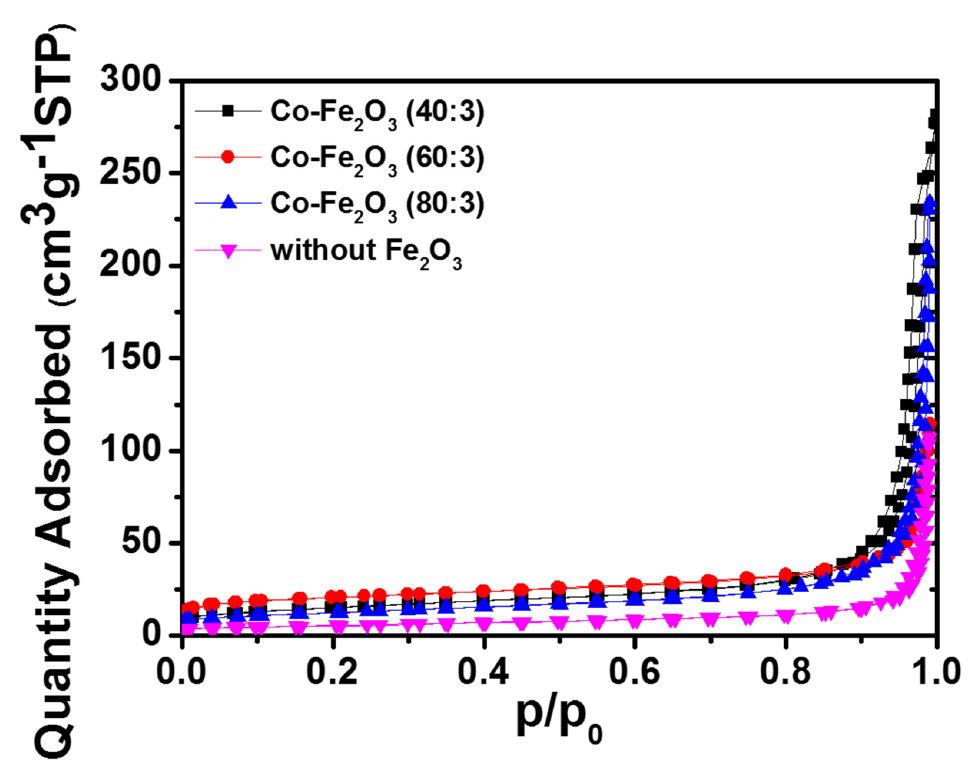
Figure 5. The nitrogen adsorption/desorption curves for different iron and cobalt precursors ratios.